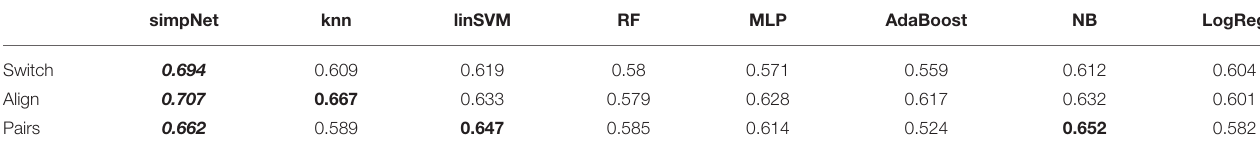
TABLE 2 | Person-dependent: Average classification accuracies over all participants if the classifier was trained in a person-dependent manner; bold and italic , highest average accuracy for this task; bold , p -value of the one-sided Wilcoxon Signed Rank Test above 0.05, thus no statistical difference between this and the best performing classifier.